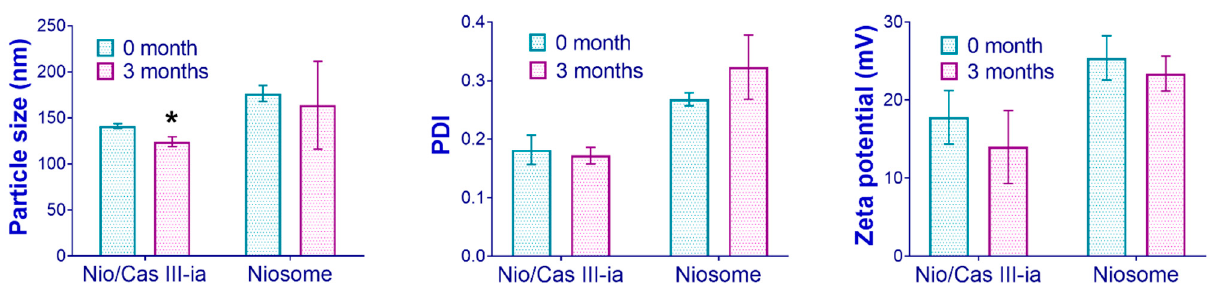
Figure 6. Accelerated stability studies (40 ◦ C and 75% RH) for CasIII-ia in niosome-optimized formulation. The unpaired t -test was used to evaluate statistically significant groups (marked with an asterisk).